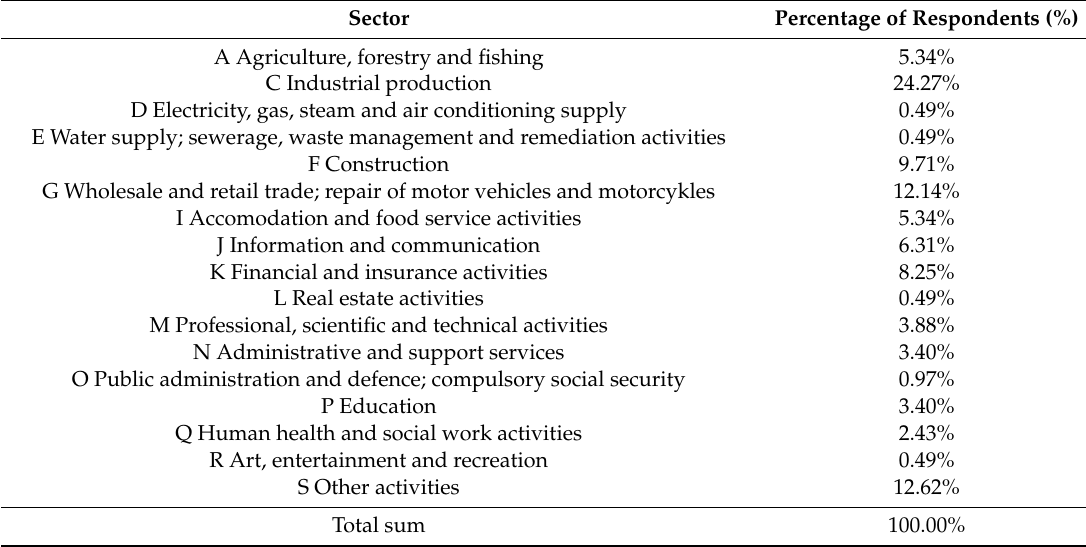
Table 2. Structure of the research sample according to industrial sectors.